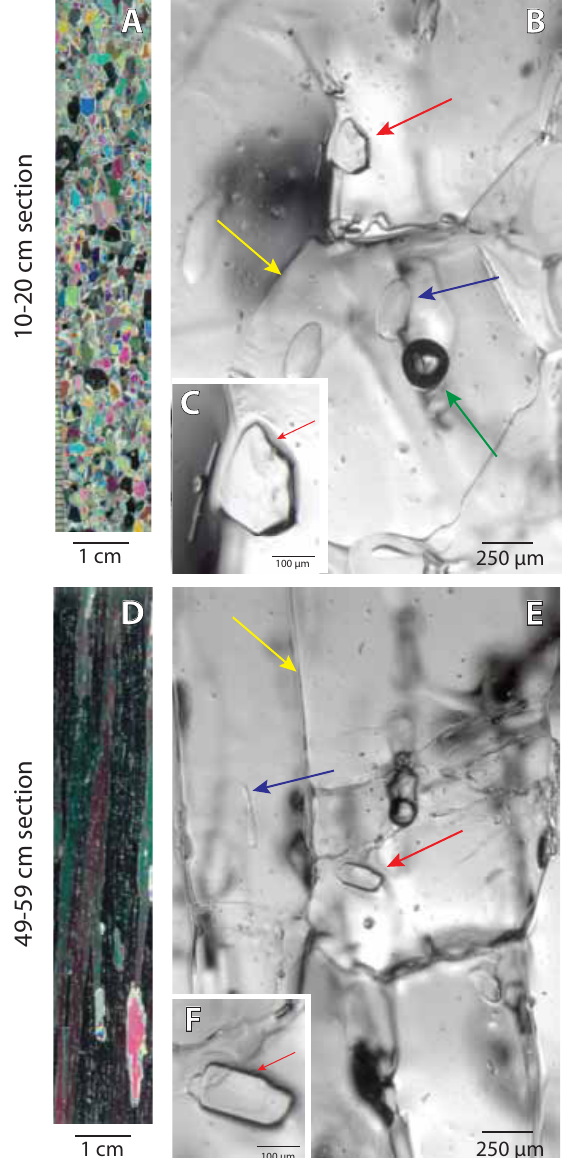
Fig. 4. Images of sea ice with ikaite crystals, from POLY I. (A, D) Sea ice texture (polarized light); (B, E) microscopic image of sea ice. Yellow arrows point to ice crystal boarders, blue arrows to brine pockets, and red arrows to ikaite crystals. (C, F) Ikaite crystals at higher magnification. (A) , (B) and (C) from 0–10cm section; (D) , (E) and (F) from 10–20cm